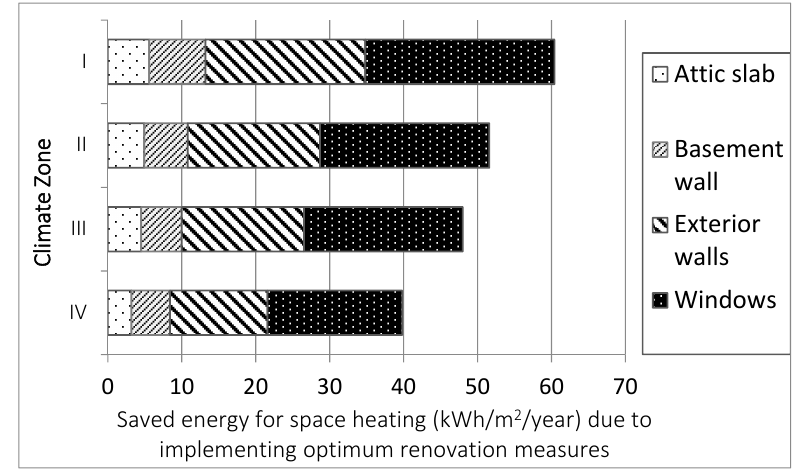
Figure 21. The saved energy for space heat demand due to implementing the optimum level of energy